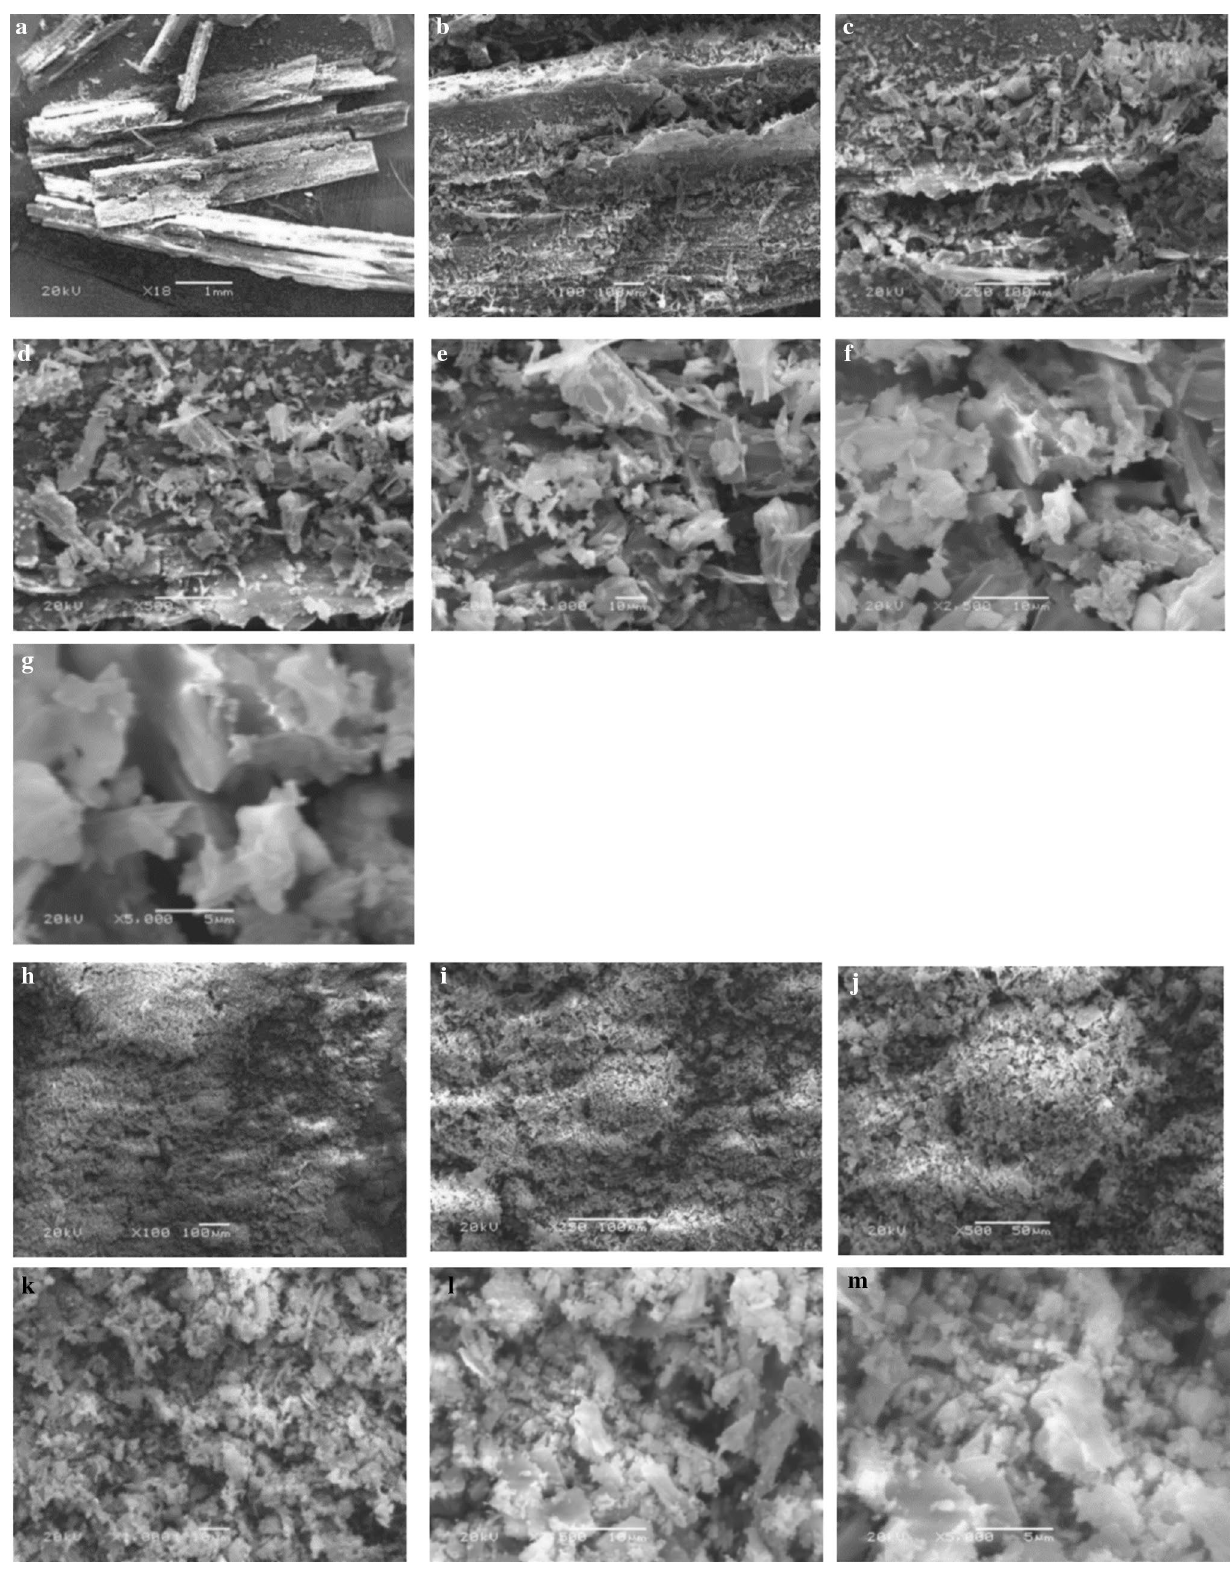
Fig. 1 The SEM images at various magnifications of the p-Biochar ( a – g ) and m-Biochar ( h – m